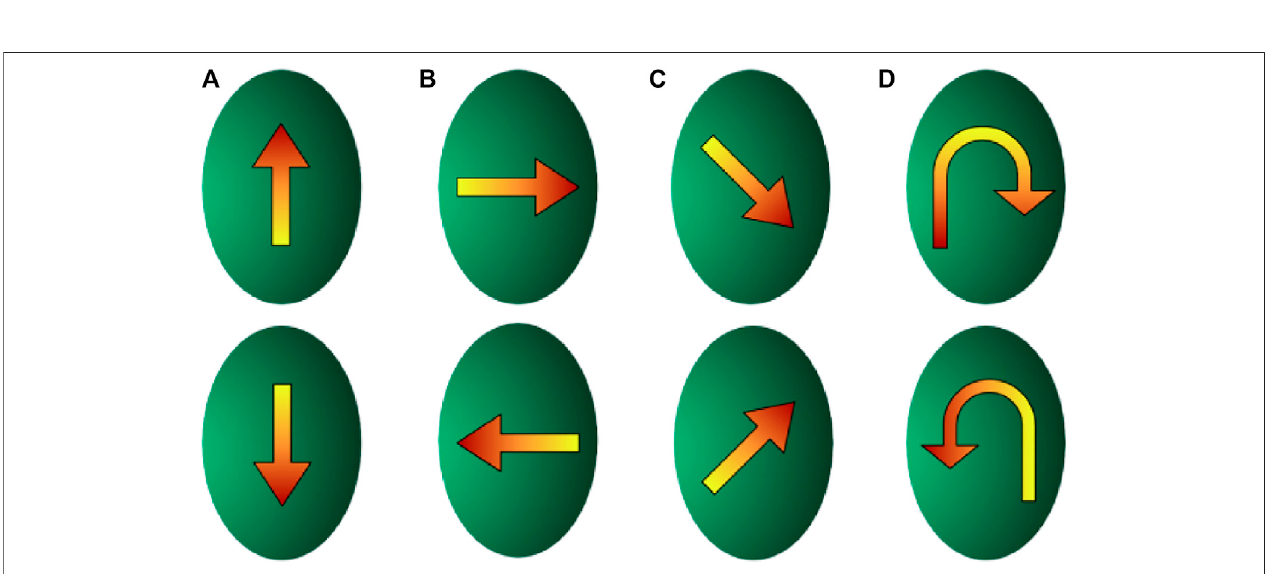
FIGURE 5 | Touch tracking trajectories. (A) Up and down trajectories, (B) left and right trajectories, (C) diagonal trajectories, (D) circular trajectories.